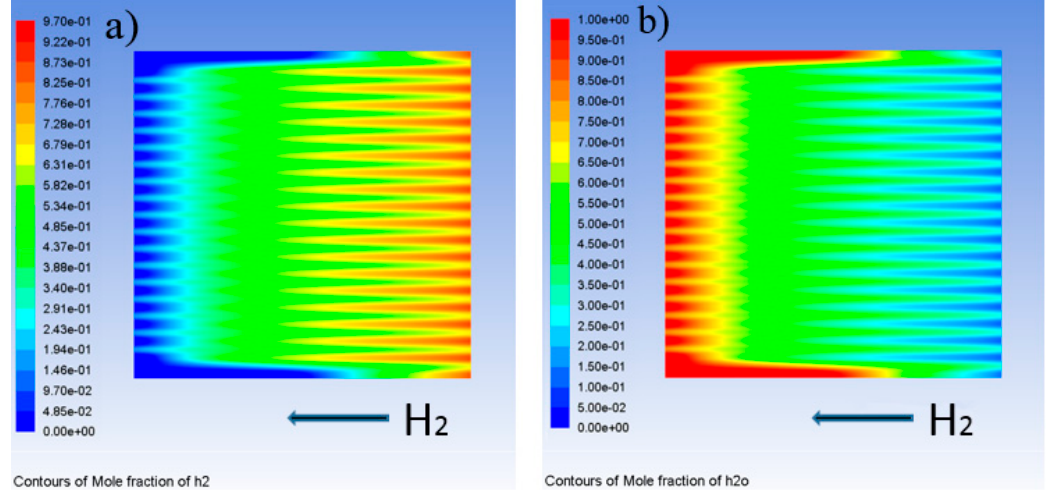
Figure 5. Mole fraction distributions over the anode–electrolyte interface: ( a ) H 2 ; ( b ) H 2 O. (note: e-01 in the figure means × 10 − 1 ).